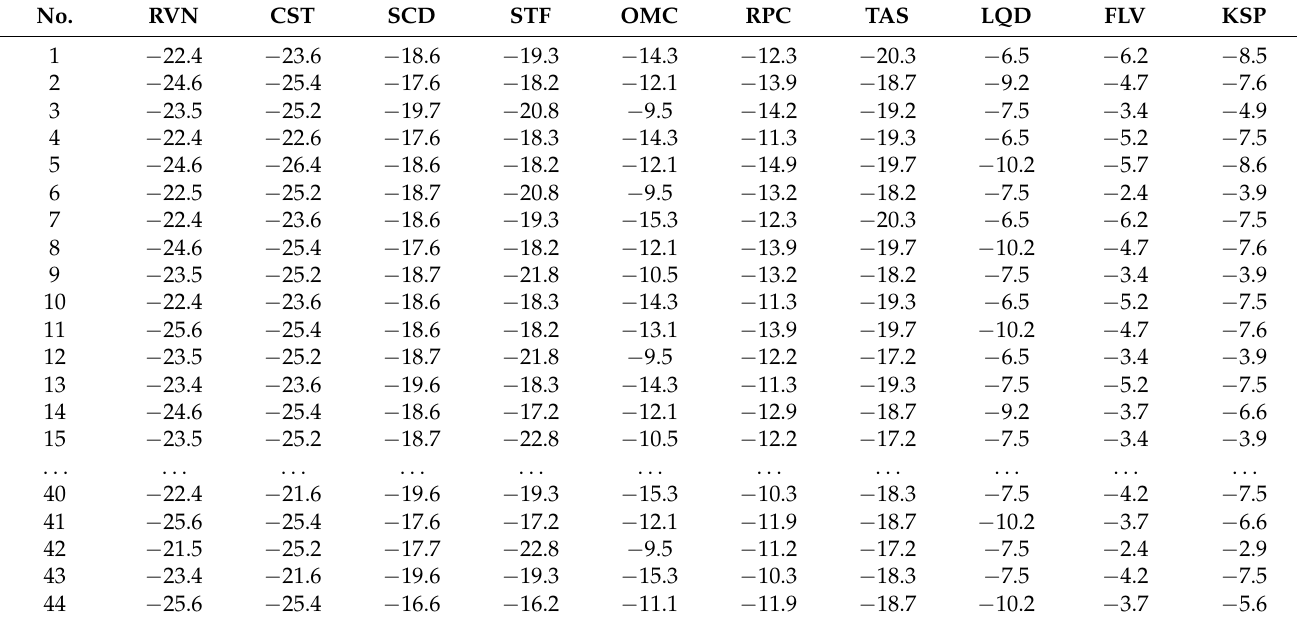
Table 13. Stationary test of endogenous